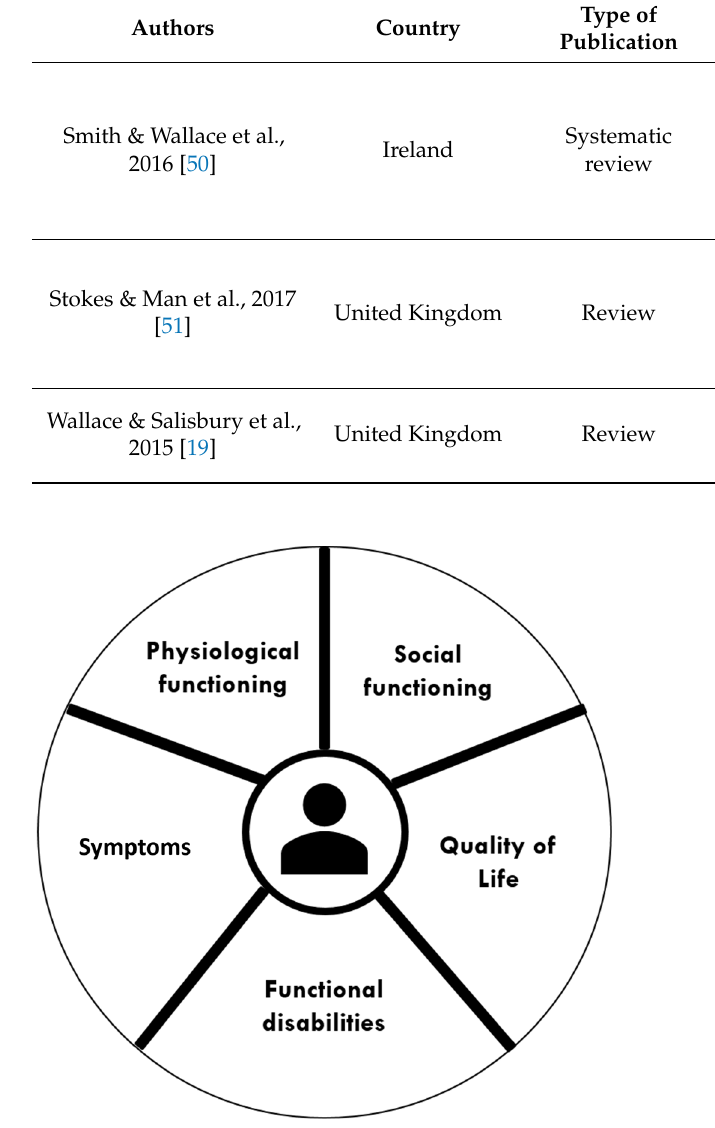
Figure 1. Domains in the concept of integral health